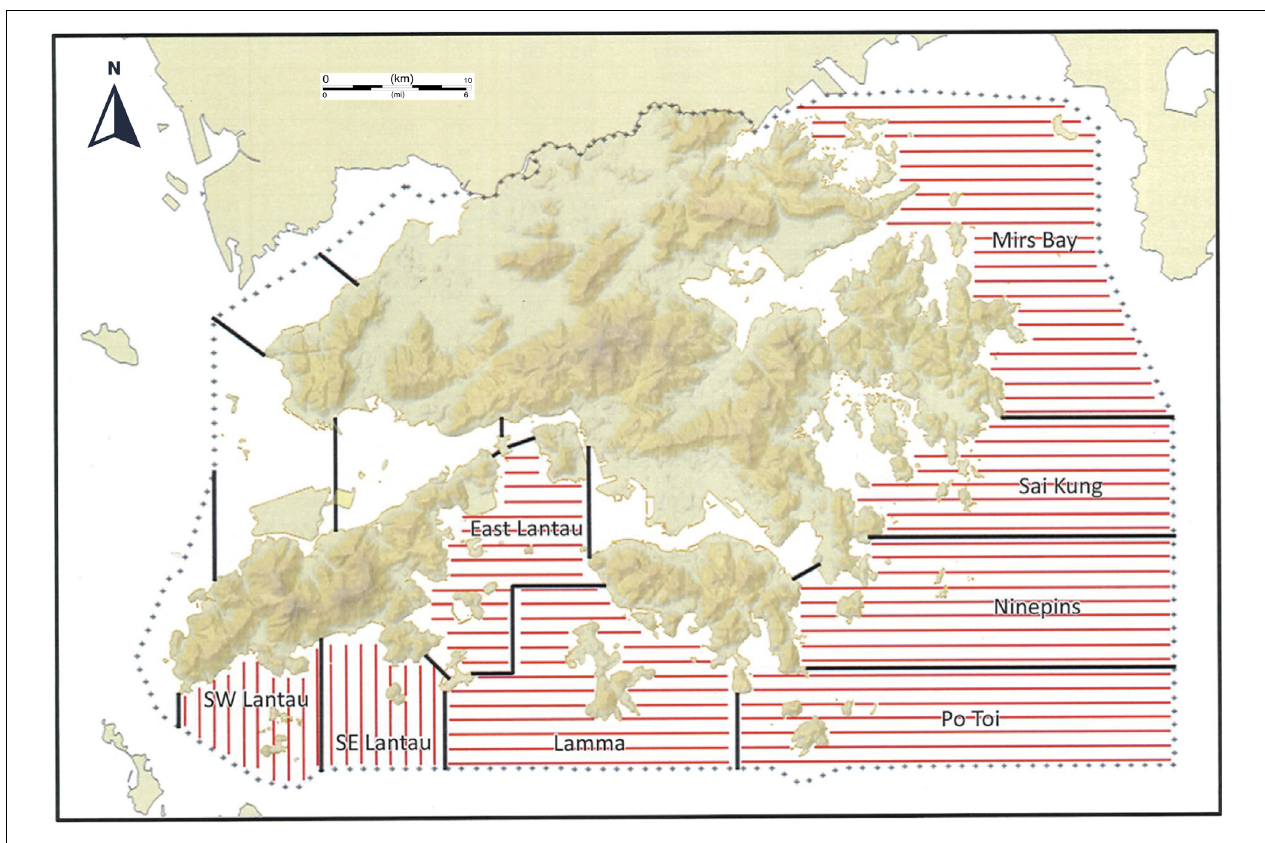
FIGURE 1 | Hong Kong, showing the survey strata, and the transect lines for those strata in which finless porpoises have traditionally been found. SW and SE Lantau strata are analyzed together in this study as South Lantau. Dolphin and porpoise use of the East Lantau area has dropped to near zero, and so this area is no longer surveyed. Areas to the west and north of Lantau Island are not used by finless porpoises, but are habitat for Indo-Pacific humpback dolphins. Mirs Bay was only surveyed by helicopter, due to its remote